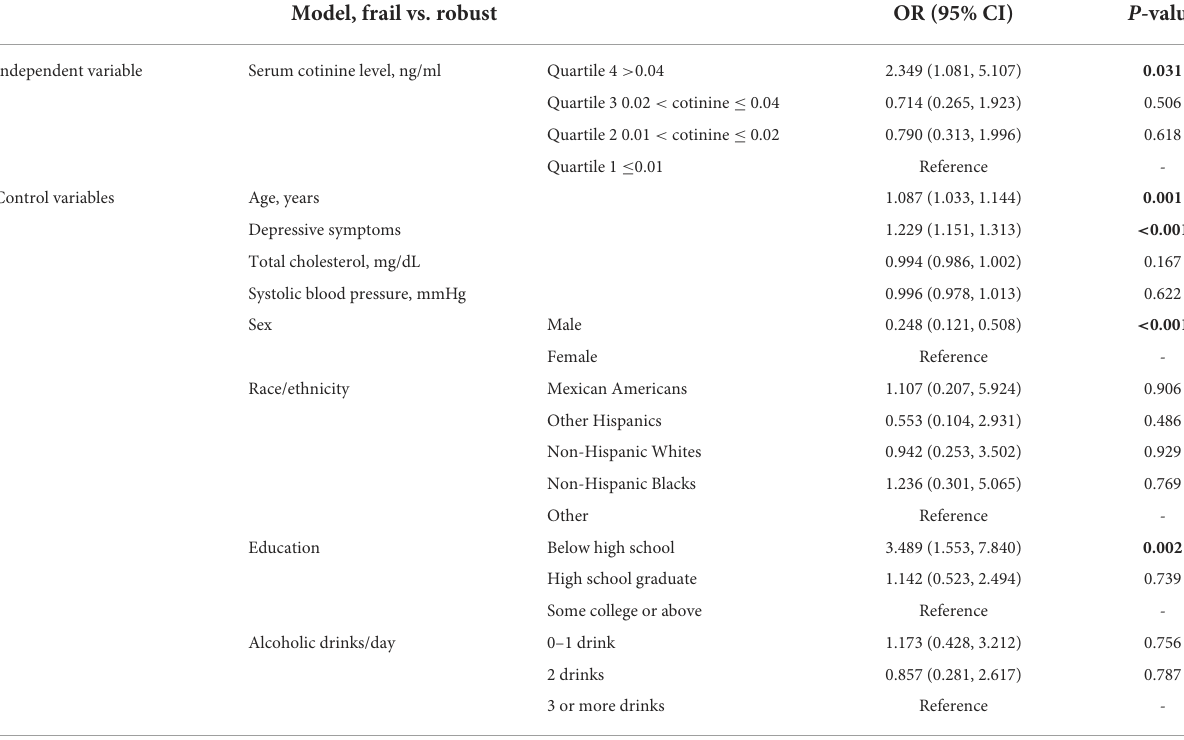
TABLE 3 The independent associations of serum cotinine level quartile (reference: ≤ 0.01ng/ml) with frailty. Model, frail vs.